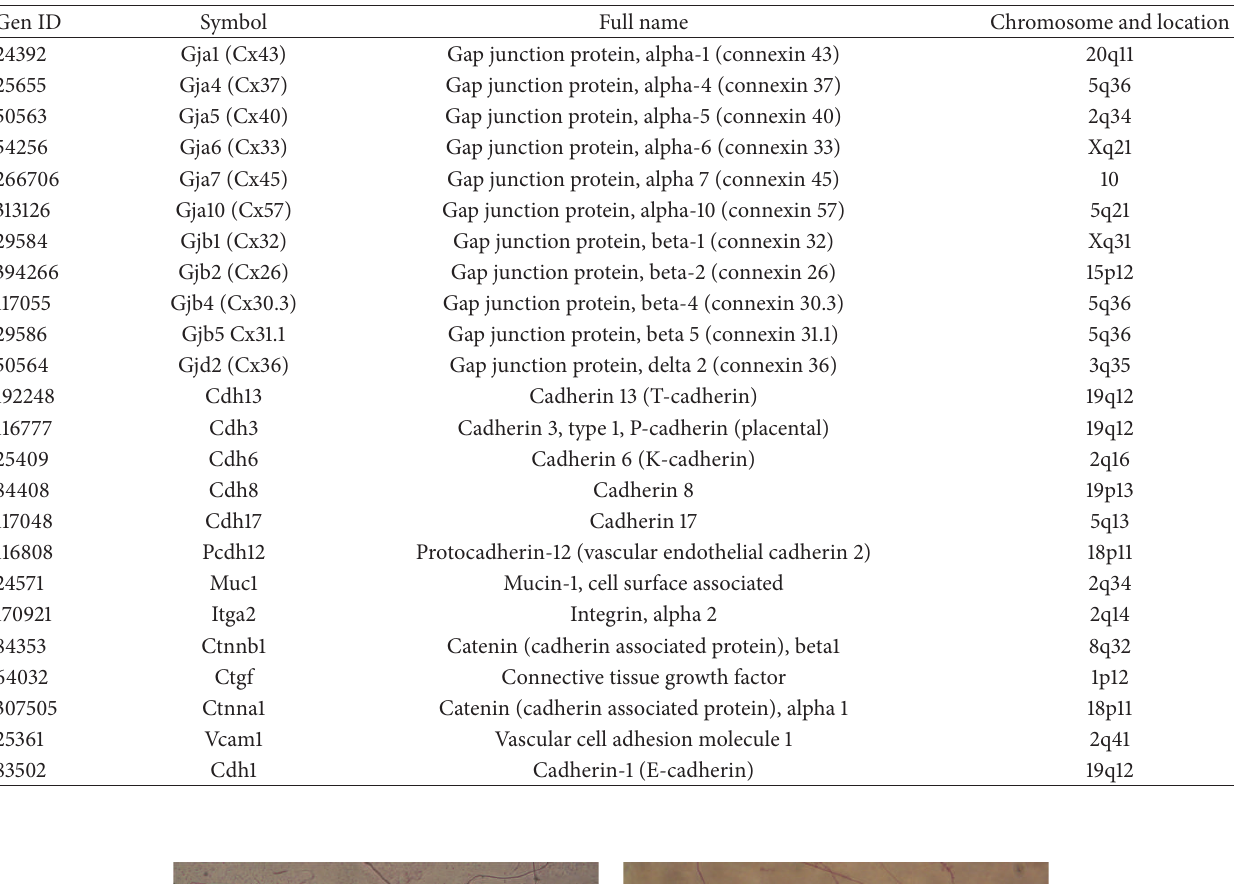
Table 1: Details of the genes analysed by quantitative RT-PCR.